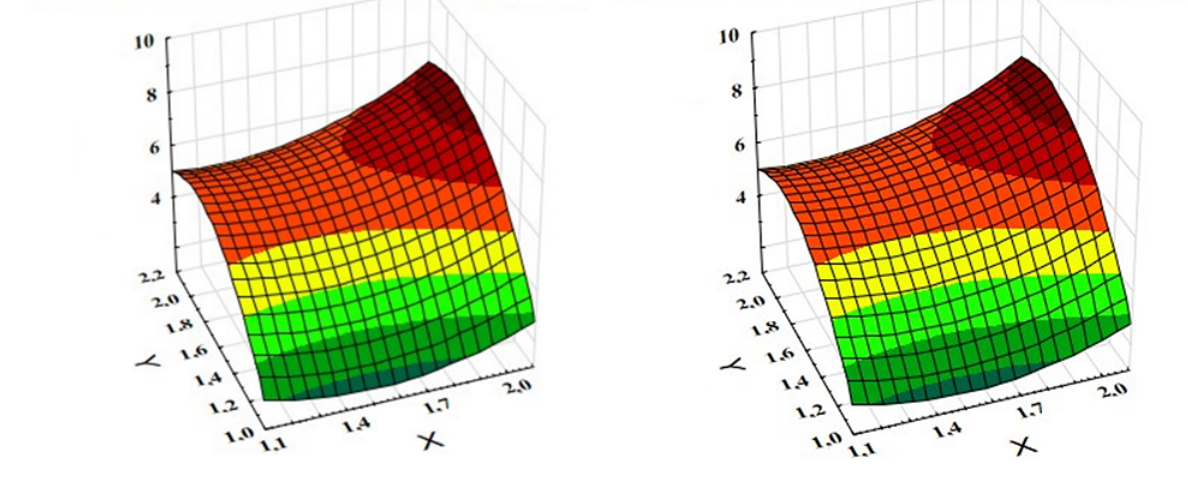
Figure 8 e regression graph of the winter wheat yield, depending on the elements of the yield structure, for the ‘Smuhlyanka’ and ‘Slavna’ (le) and ‘Kubus’ and ‘Mulan’ (right) cultivars. Note: X – productive tillering; Y – grain weight per spike (g).